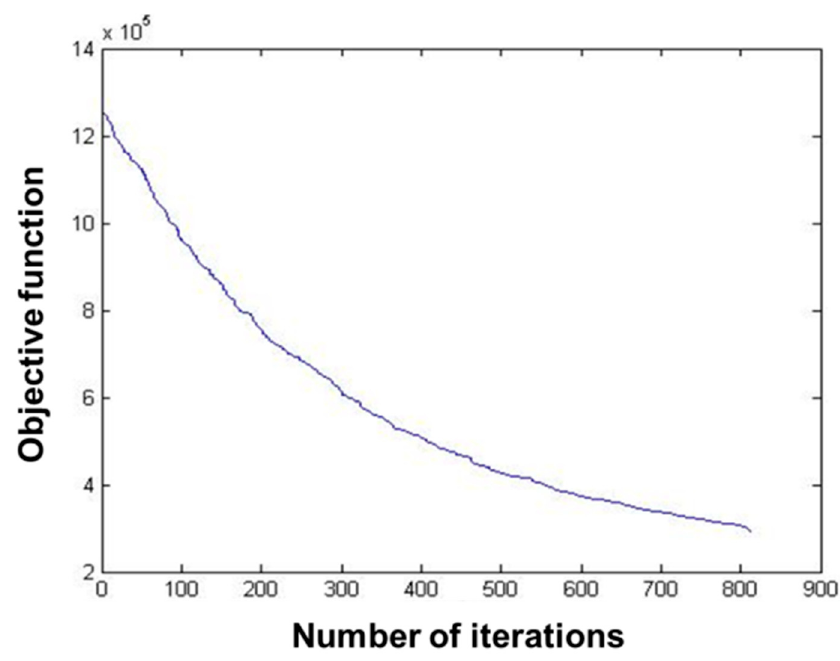
Figure 9. Convergence trajectory of simulated annealing.